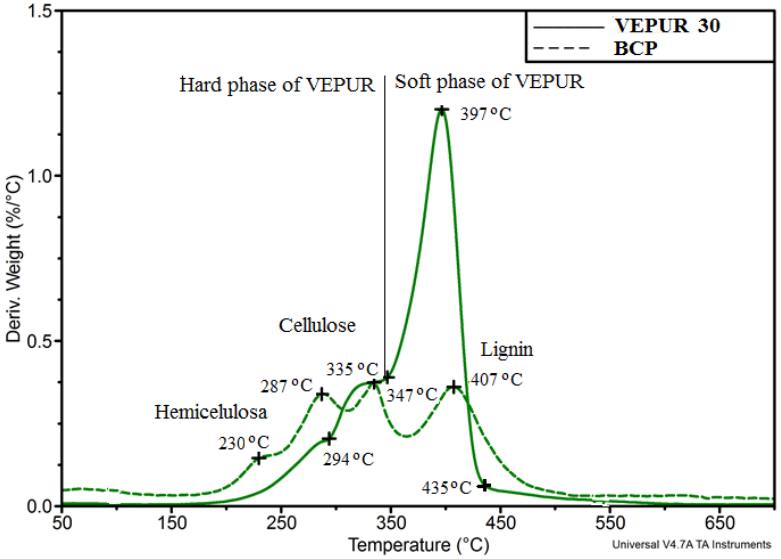
Figure 13. Comparison of DTG of BCP and VEPUR 30 curves.